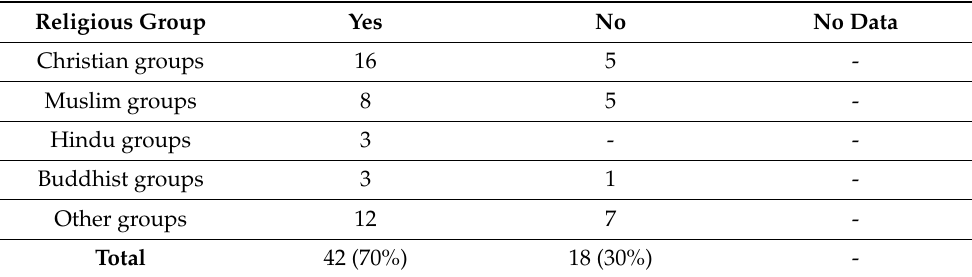
Table 2. Research question 2: Did you increase your online activities during the crisis?